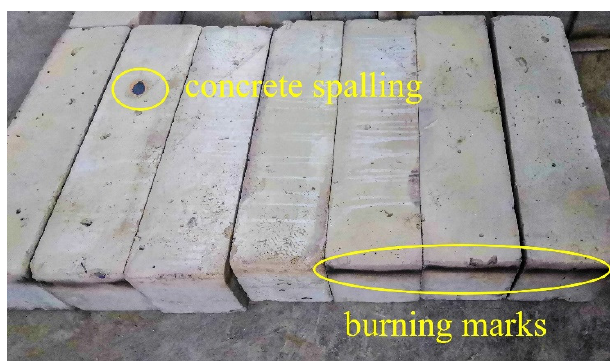
Figure 9. Apparent form of SFRC post-fire.